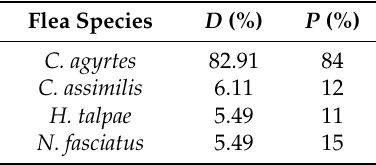
Table 3. Quantitative structure of fleas collected from small mammals captured in eastern Poland ( D —ecological indices of dominance, P —prevalence).